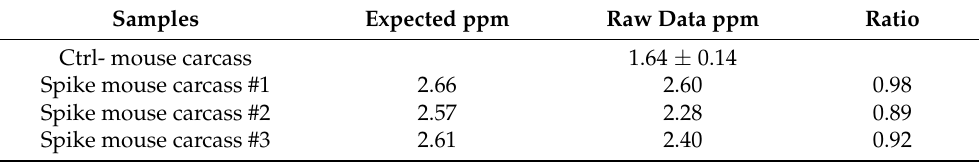
Table 7. Recovery ratios for mouse carcass after digestion in HNO 3 /H 2 O 2